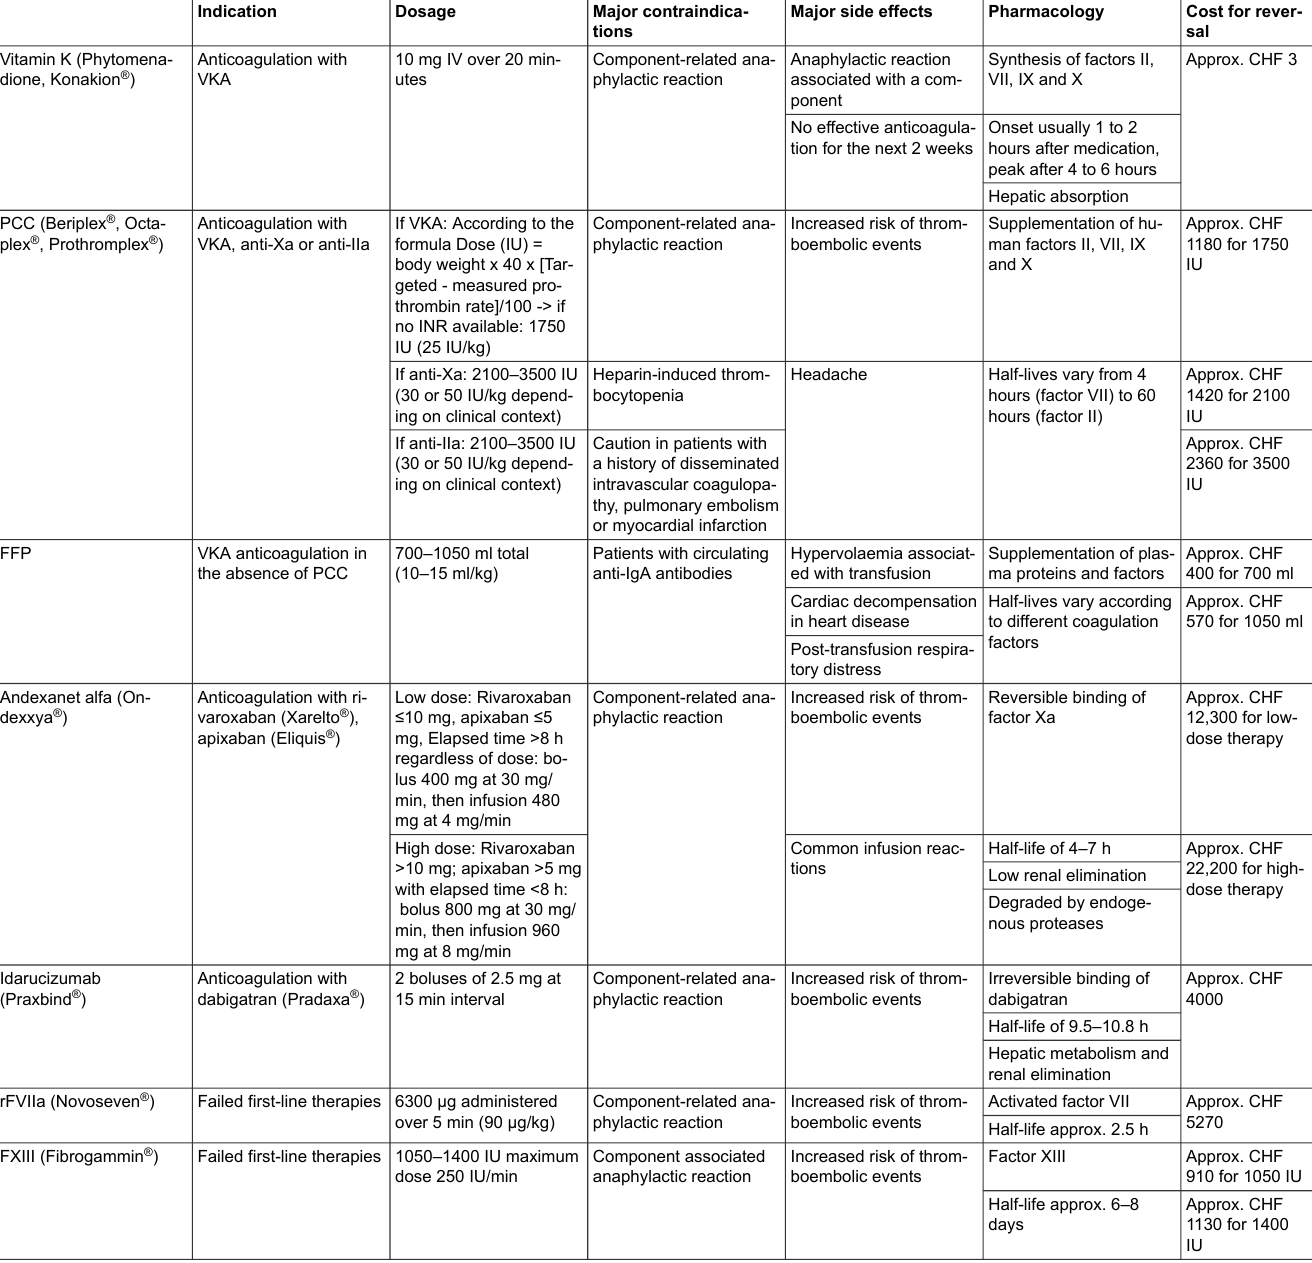
Table 5: Drugs administered to neutralise anticoagulation of different anticoagulants and the effective cost of drugs administered for a 70 kg adult patient. Indication